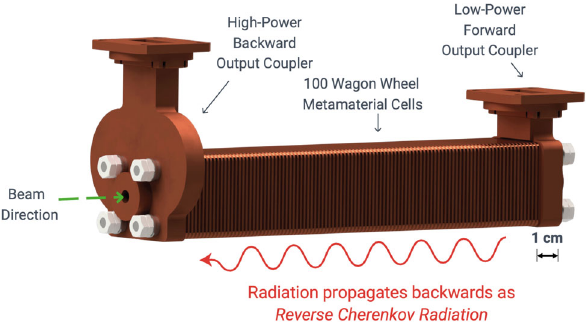
FIG. 8. A CAD model of the Stage III structure, including symmetric high power output coupler and asymmetric low-power forward coupler.